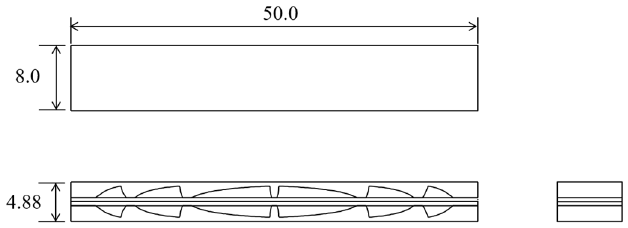
Figure 10. A design of tunable stiffness organ-grasping device using the PSL-thickness